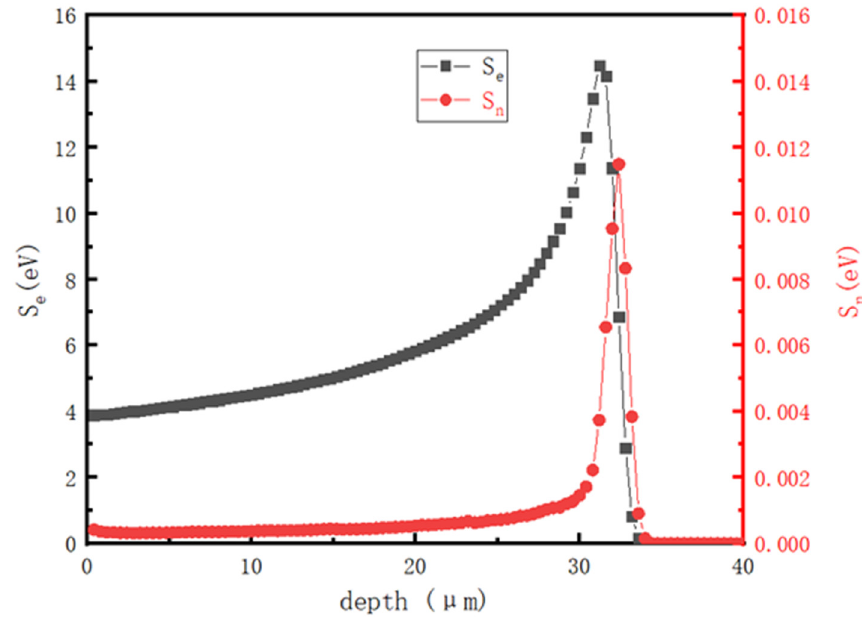
Figure 4. Nuclear energy loss and electron energy loss with SRIM calculation of 2 MeV H + inducing 4H-SiC.